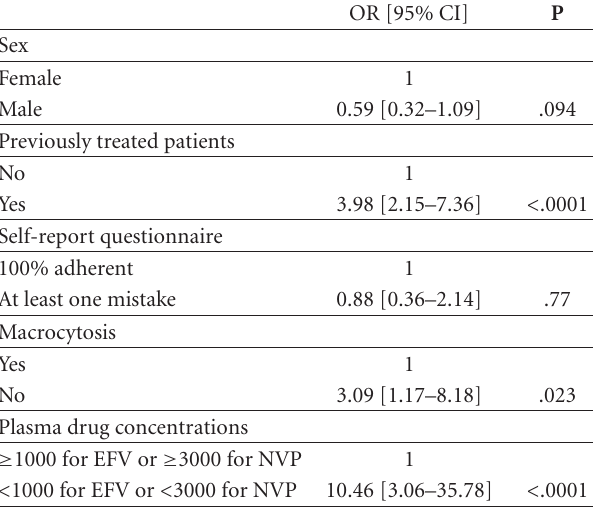
Table 4: Multivariate logistic regression: factors associated with virological failure ( N =